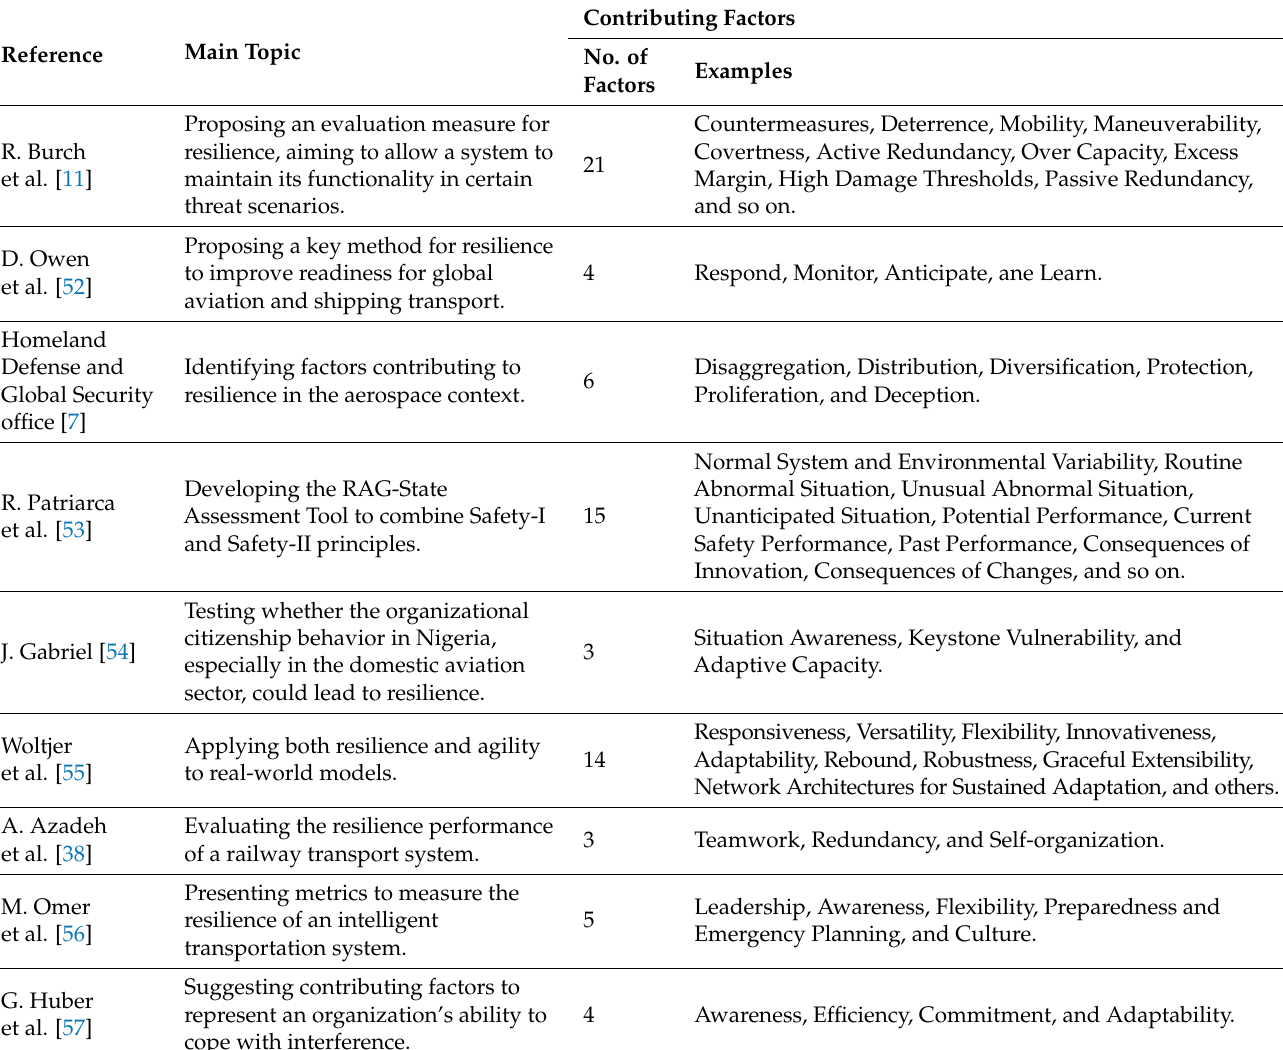
Table 5. Summary of identified contributing factors from the transportation